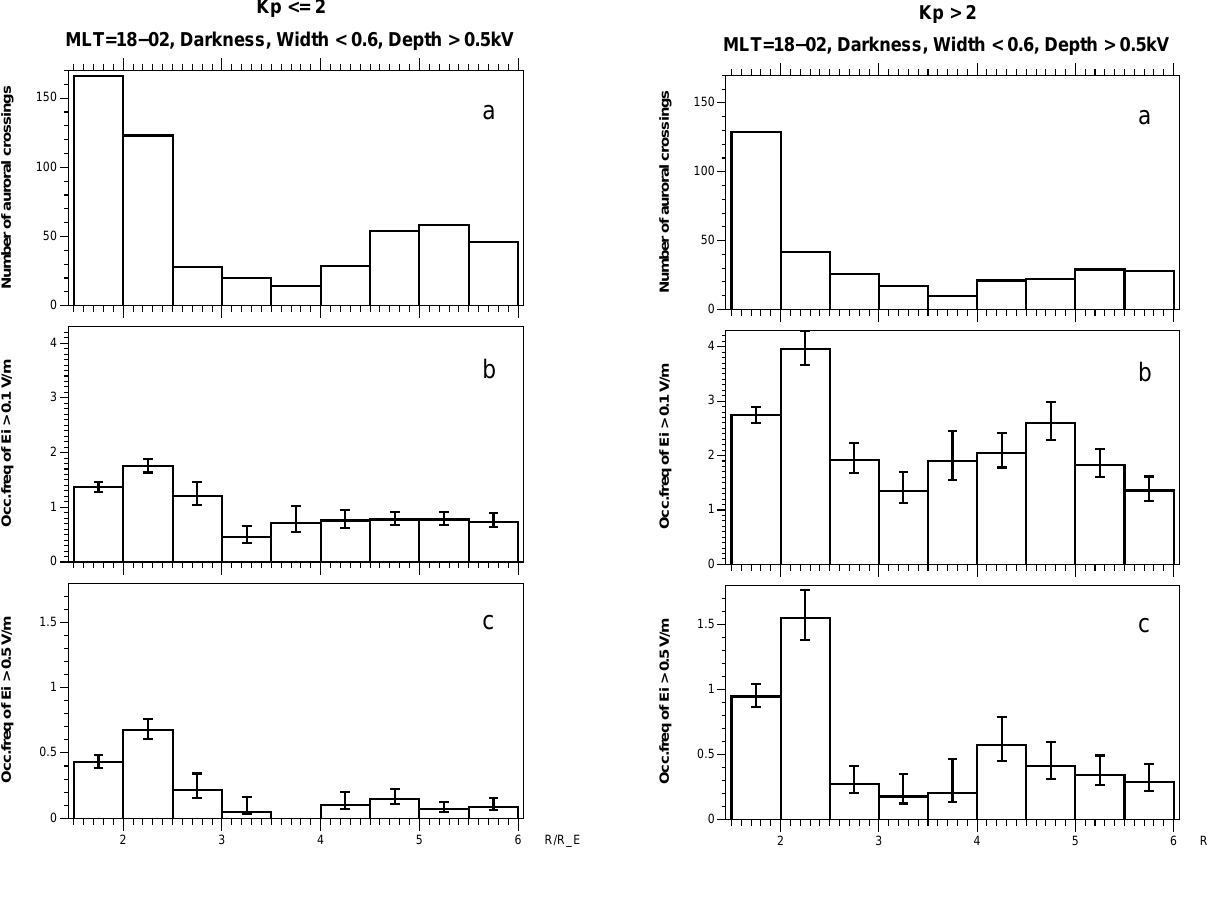
Fig. 2. From five years of Polar/EFI data: auroral potential minima deeper than 0.5kV in 18–02MLT range and the corresponding effective ionospheric electric fields E i when the ionospheric footpoint is in darkness: (a) number of auroral crossings in each radial bin, (b) occurrence frequency of E i being larger than 100mV/m, (c) occurrence frequency of E i being larger than 500mV/m. Left plot is for K p ≤ 2 and right plot for K p > 2. Only structures whose ionospheric width is smaller than 0.6 ◦ ( ∼ 60km) are